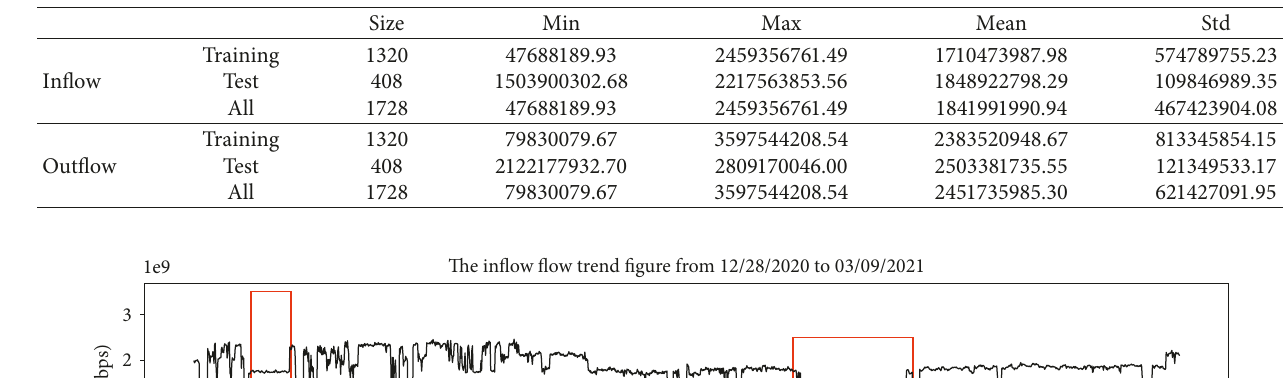
Table 1: Statistical description for the investigated datasets.